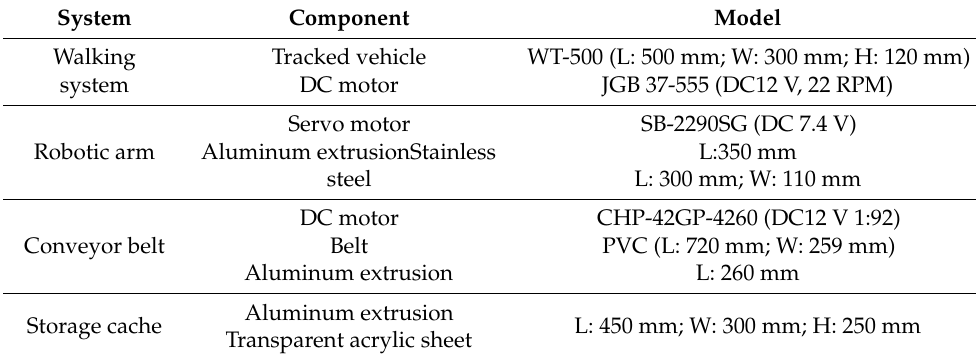
Table 1. Components and systems of the designed chicken removal